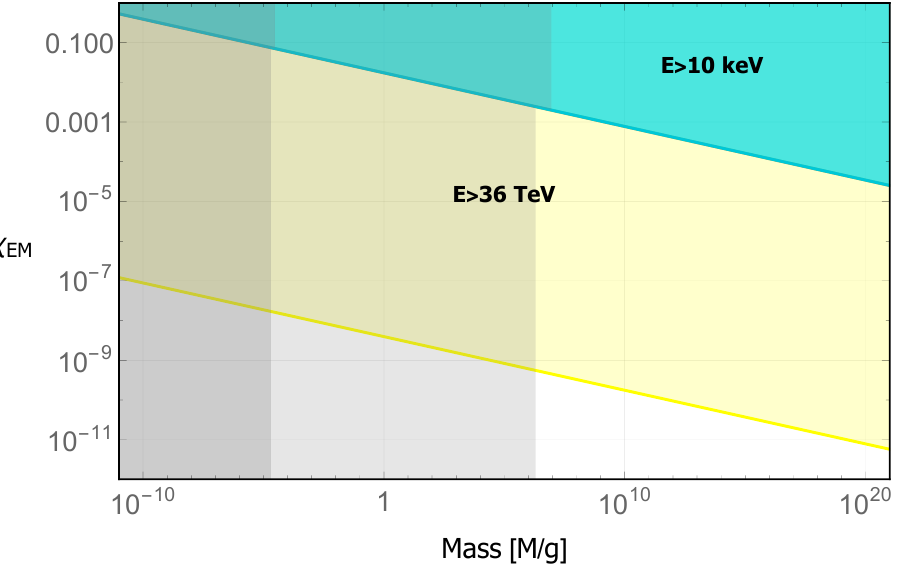
Figure 1 . Limits on χ EM for blobs that satisfy (2.26) when f = 1 . The yellow region excludes χ for EM particles with E > 36 TeV. These are reprocessed into gamma-rays whose flux would be greater than that observed by Fermi-Lat. The blue region excludes χ for EM particles with E > 10 keV. These increase the free electron fraction and distort the CMB anisotropy angular power spectrum if emitted at z ∼ 1200 . Blobs with M > 10 21 g and f = 1 are ruled out by lensing searches [32]. The gray regions show where thermal couplings to the SM bath can give blobs too much kinetic energy at z d to produce binaries as expected. This suppresses the merger rate and is described in section 2.1. Blobs in the dark gray region only produce a signal if they never thermally couple with the SM. Those in the light gray region produce a signal as long as they thermally decouple from the SM bath early enough, see eq. (2.13), to redshift away their excess kinetic energy. The remaining blobs will produce the expected signal even if they remain thermally coupled to the SM bath through z d . The gray regions are slightly offset for the different signals because these come from mergers taking place at different times. The binaries involved in these mergers have different z d and different sensitivities to the blob temperature at z d